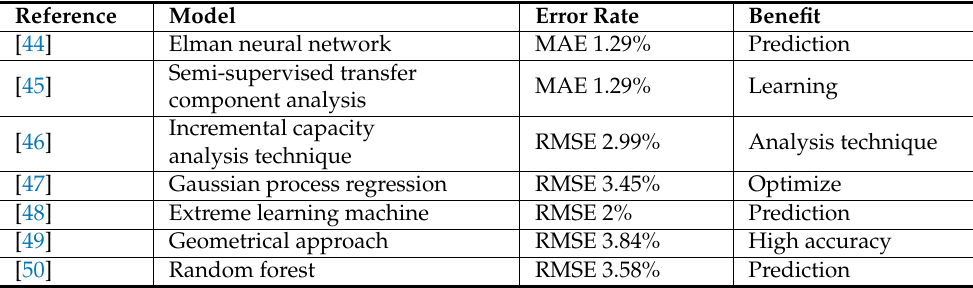
Table 1. Related studies on lithium-ion batteries in machine